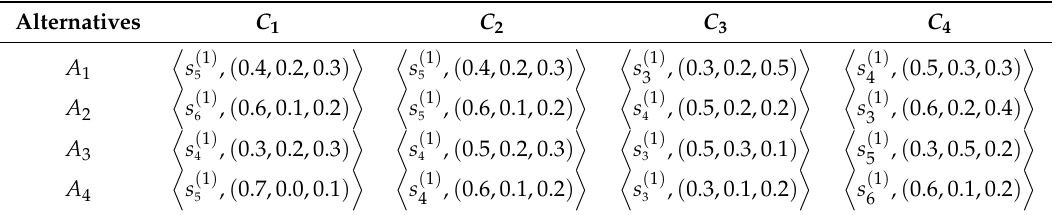
Table 4. Standardized SVNL decision matrix R 1